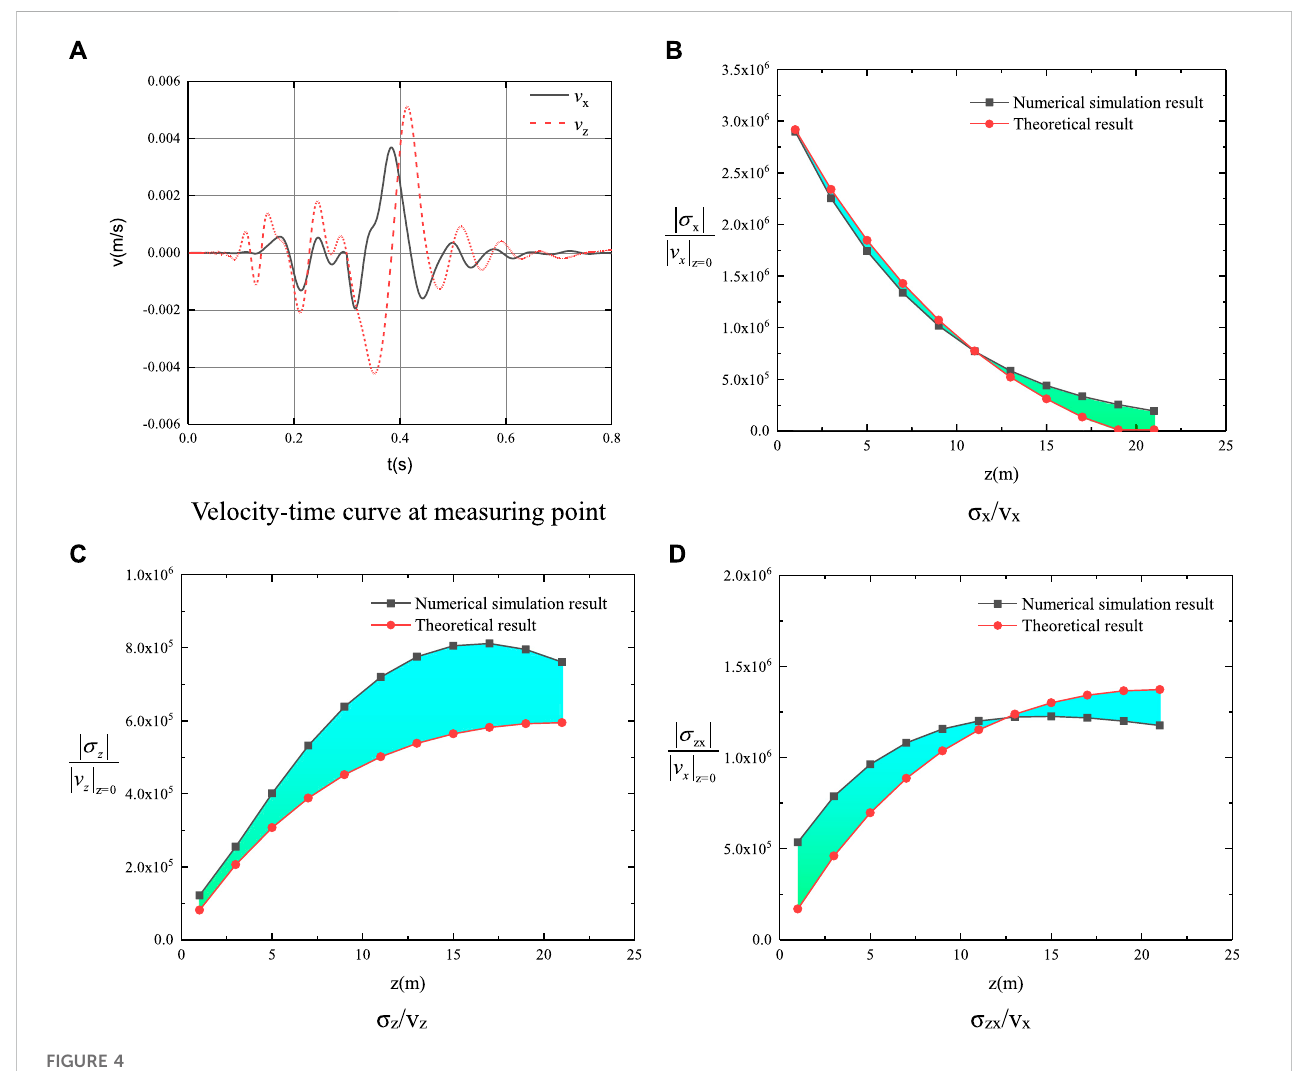
FIGURE 4 Calculation results of case 2 (A) Velocity-time curve at measuring point (B) σ x /v x (C) σ z /v z (D) σ zx /v x .